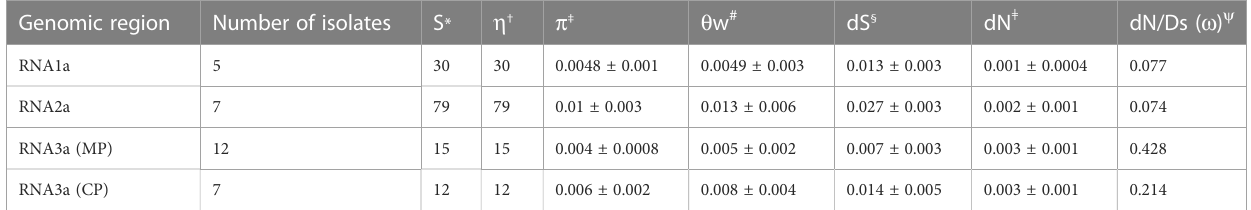
TABLE 5 Population genetics parameters for encoded region of selected United States brome mosaic virus isolates calculated using DnaSP (Librado and Rozas, 2009) and MEGA X (Kumar et al., 2018). Genomic